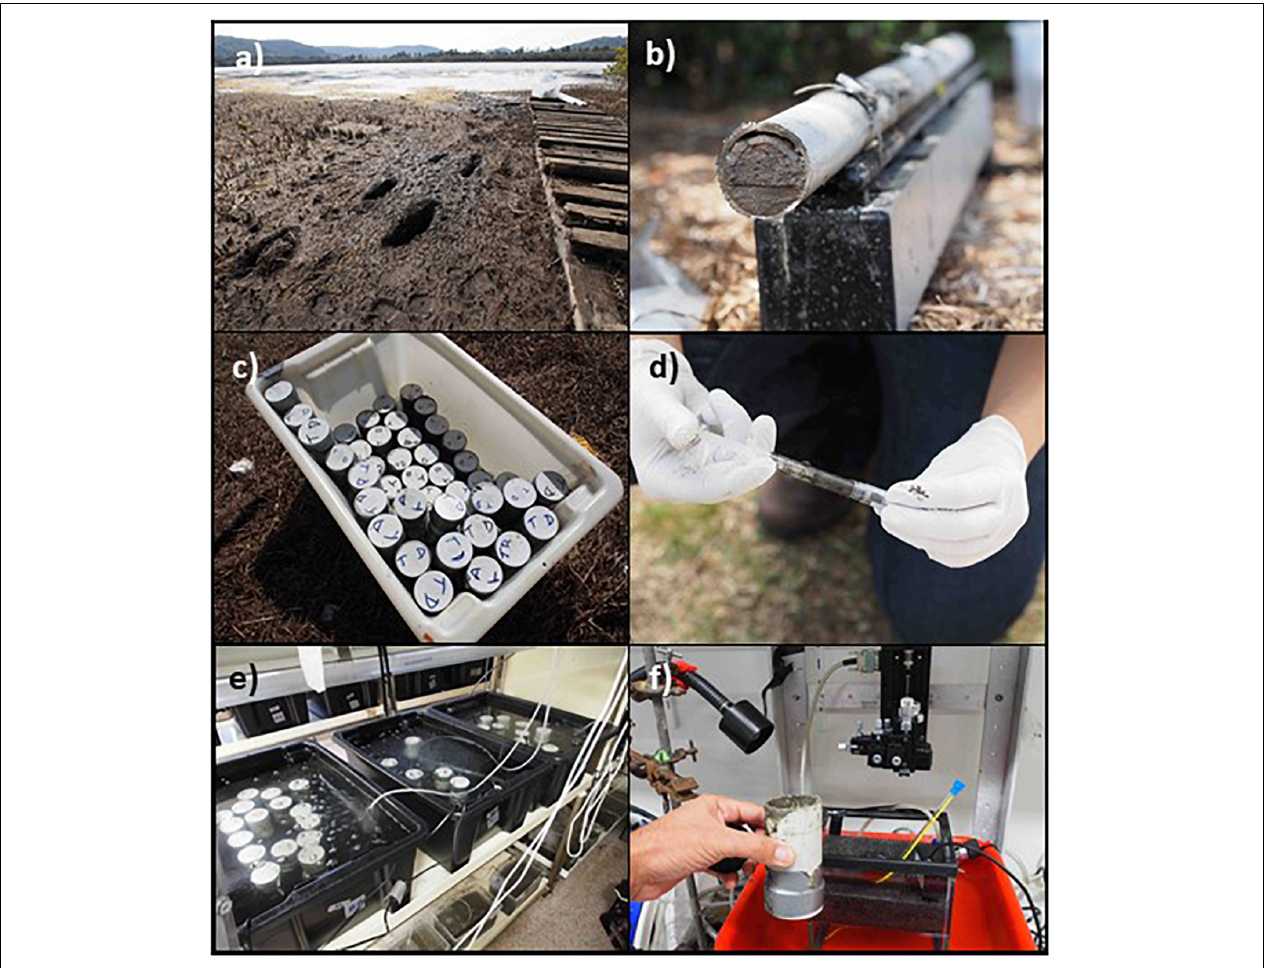
FIGURE 1 | Experimental design and sediment sampling. Pictures shows (a) the Fagans Bay study site at low tide; (b) full-length core undergoing sectioning; (c) collection of sectioned cores; (d) syringe corer extruding sediment for further analyses (incl. porosity determinations); (e) cores undergoing incubation in laboratory mesocosms; and (f) the microsensor setup for profiling pH, O 2 and H 2 S concentrations in the